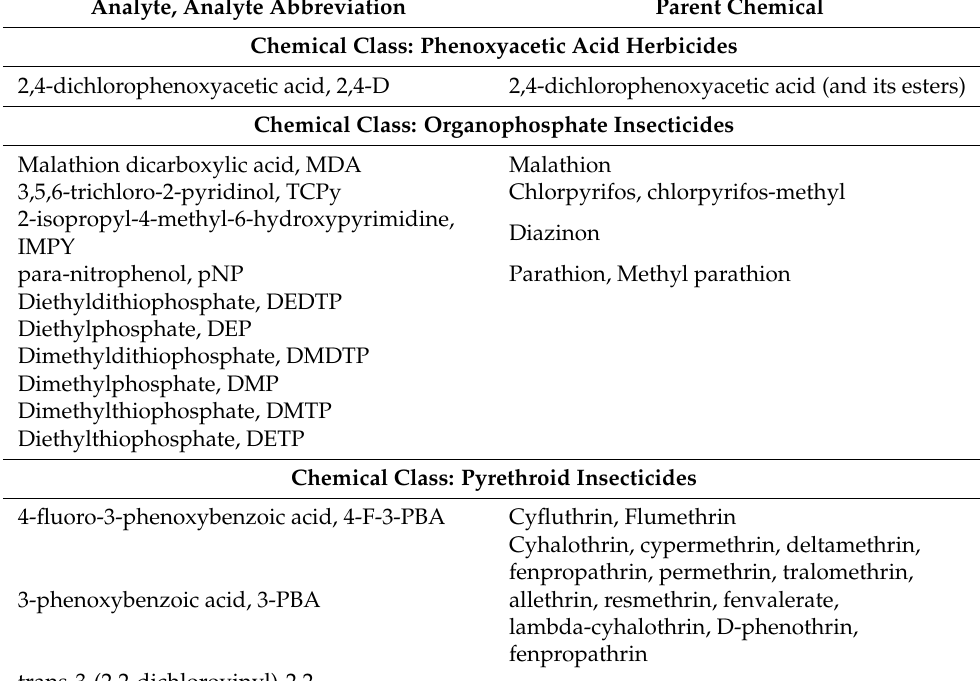
Table 1. Chemical Class and Associated Parent